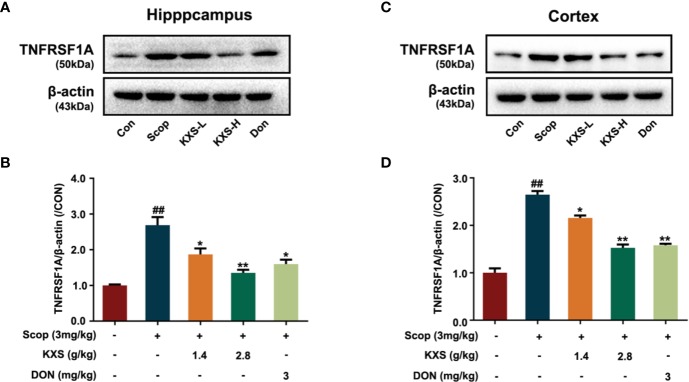
Kai-Xin-San (KXS) decreases the protein expression of tumor necrosis factor receptor superfamily member 1A (TNFRSF1A) in scopolamine (SCOP)-induced mice. Western blot analysis showing the protein expression levels of TNFRSF1A in the hippocampus (A) and cortex (C). Quantiﬁcation of TNFRSF1A levels in panel (A, B) or (C, D) was normalized to that of actin. Data represent the means ± SEM (n=3, ##P < 0.01 versus the control group; *P < 0.05, **P < 0.01 versus the SCOP group).